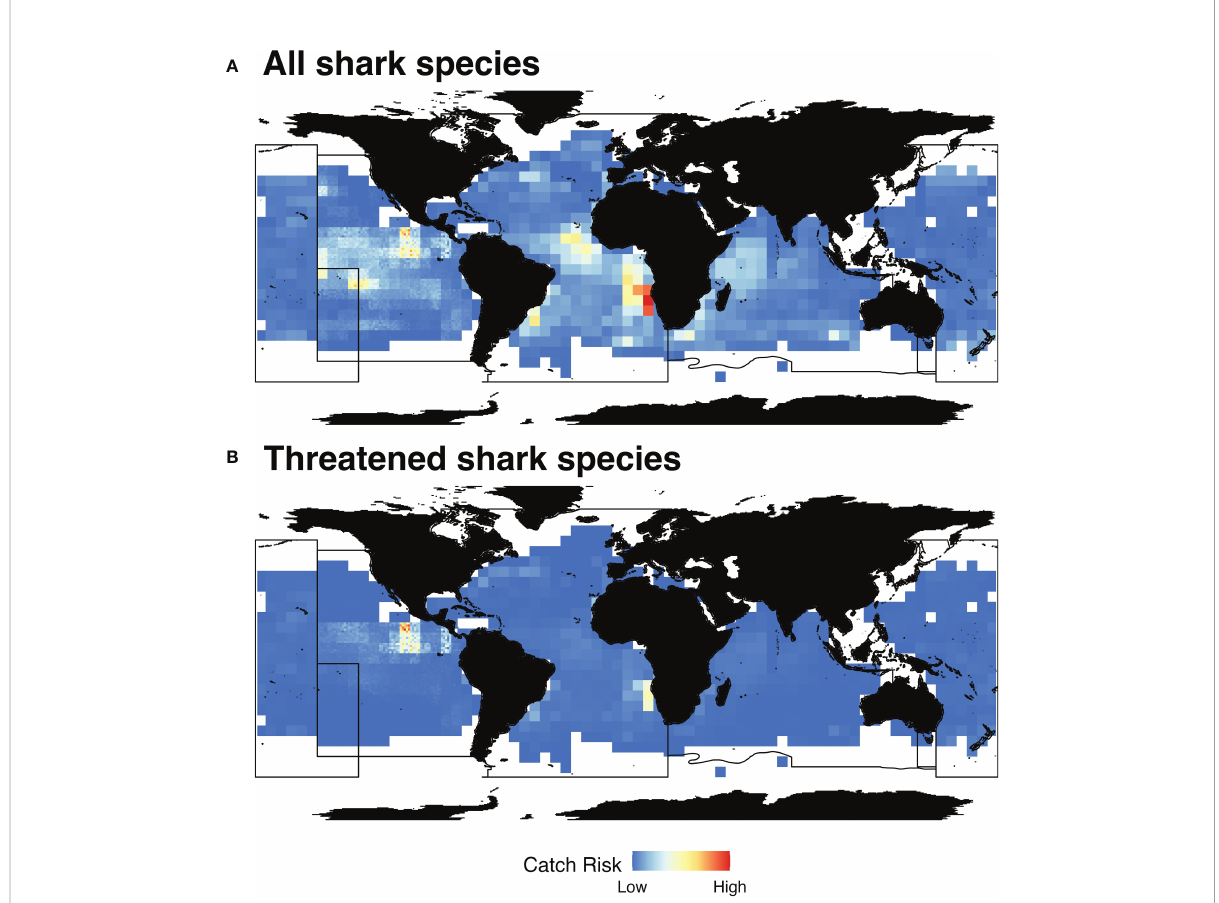
FIGURE 3 Shark catch risk. Estimated spatial risk for shark catch at a global scale for all tRFMO reported shark species combined (A) and threatened shark species (Critically Endangered, Endangered, and Vulnerable by the IUCN) (B) . Areas in blue represent low shark catch risk, while areas in red represent high shark catch risk. Black lines represent tRFMO